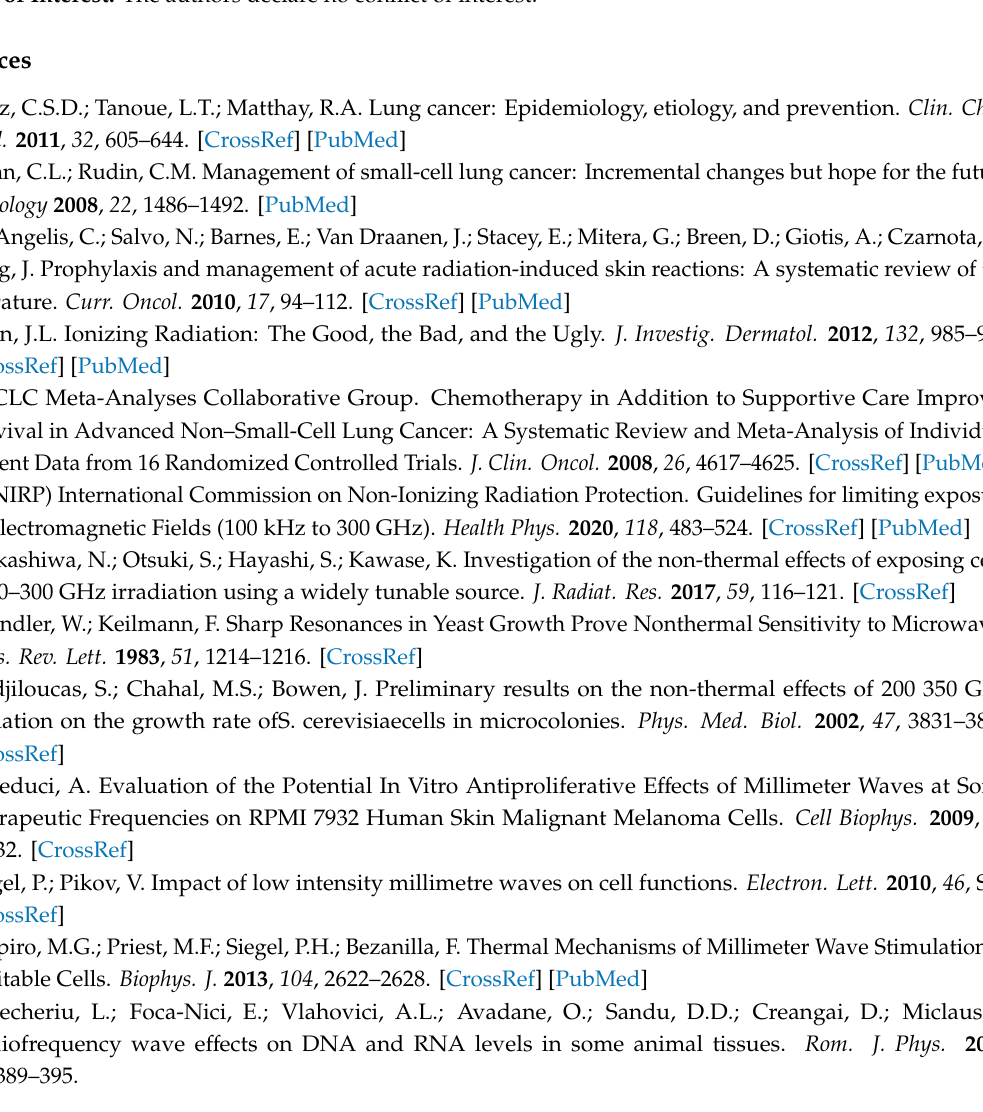
Table S1. Fold Changes (the indicated values represent ratios of fold change with reference to